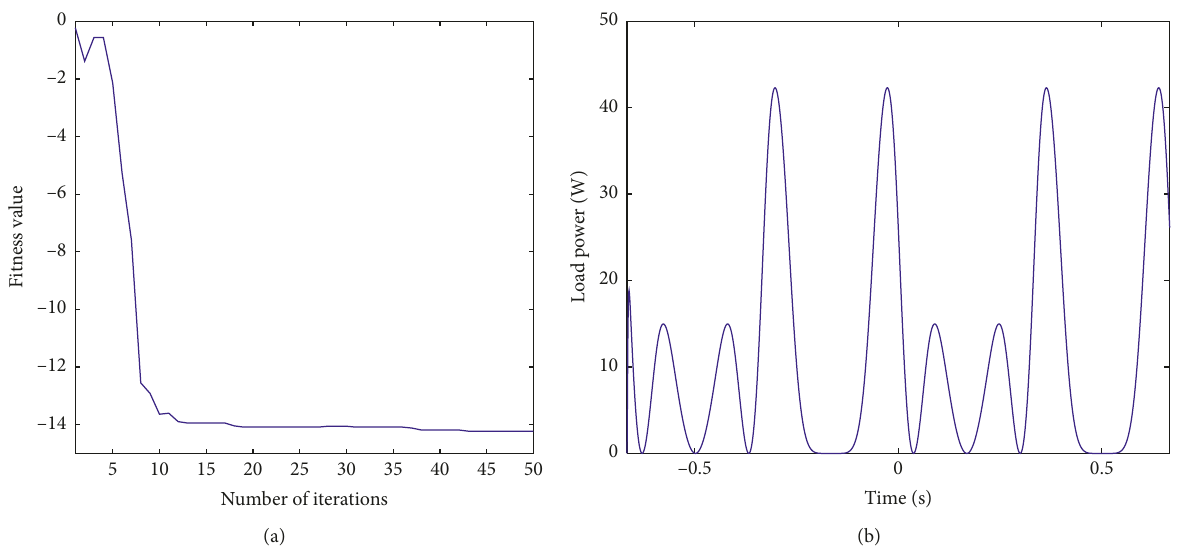
Figure 4: Optimization results. (a) Optimization process. (b) Instantaneous power under optimal